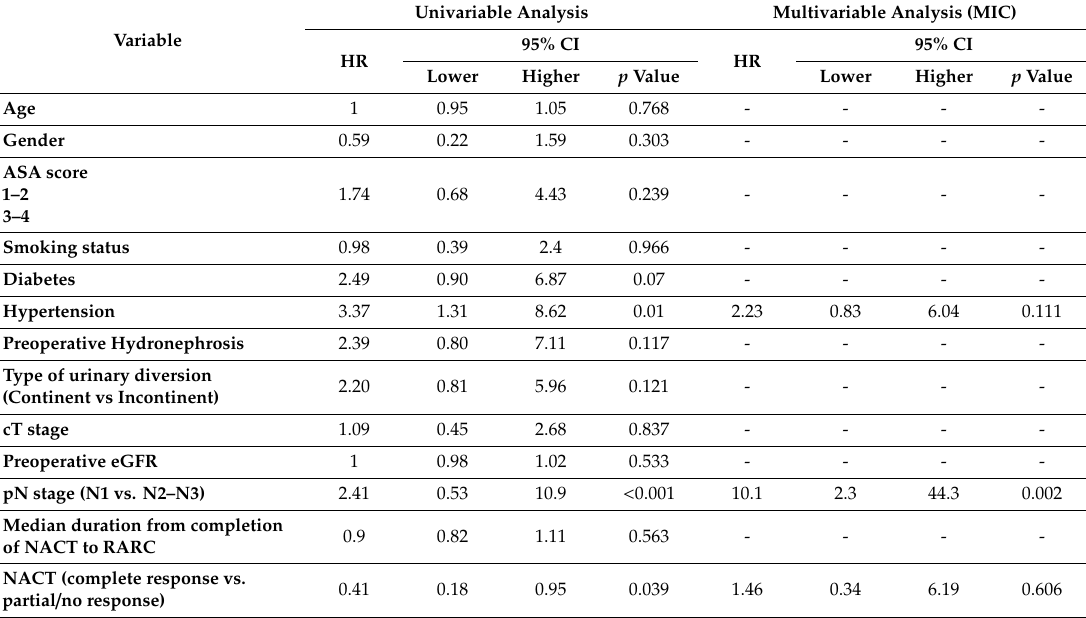
Figure 1. Kaplan–Meier curve showing OS probability according to NACT response. Table 3. Univariable and multivariable Cox regression analysis to identify predictors of